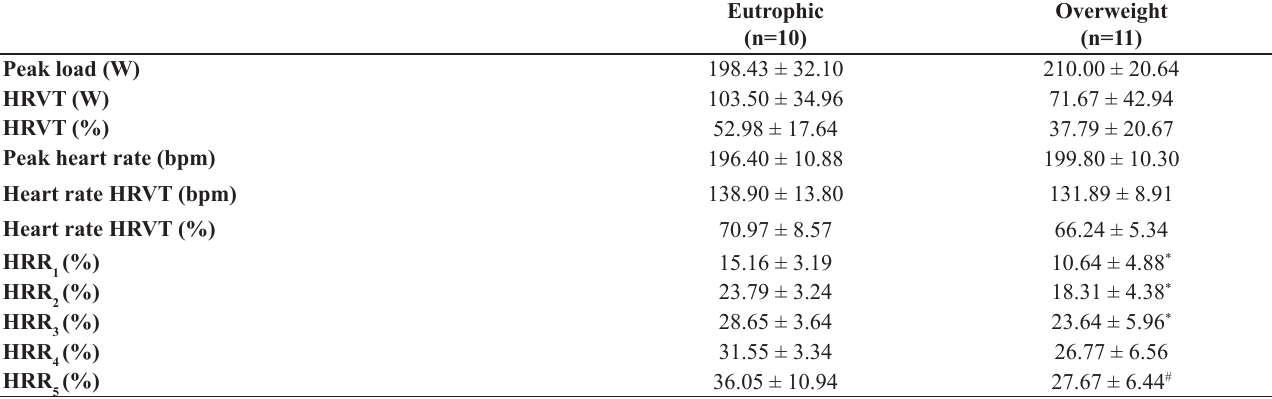
Eutrophic Overweight (n=10)